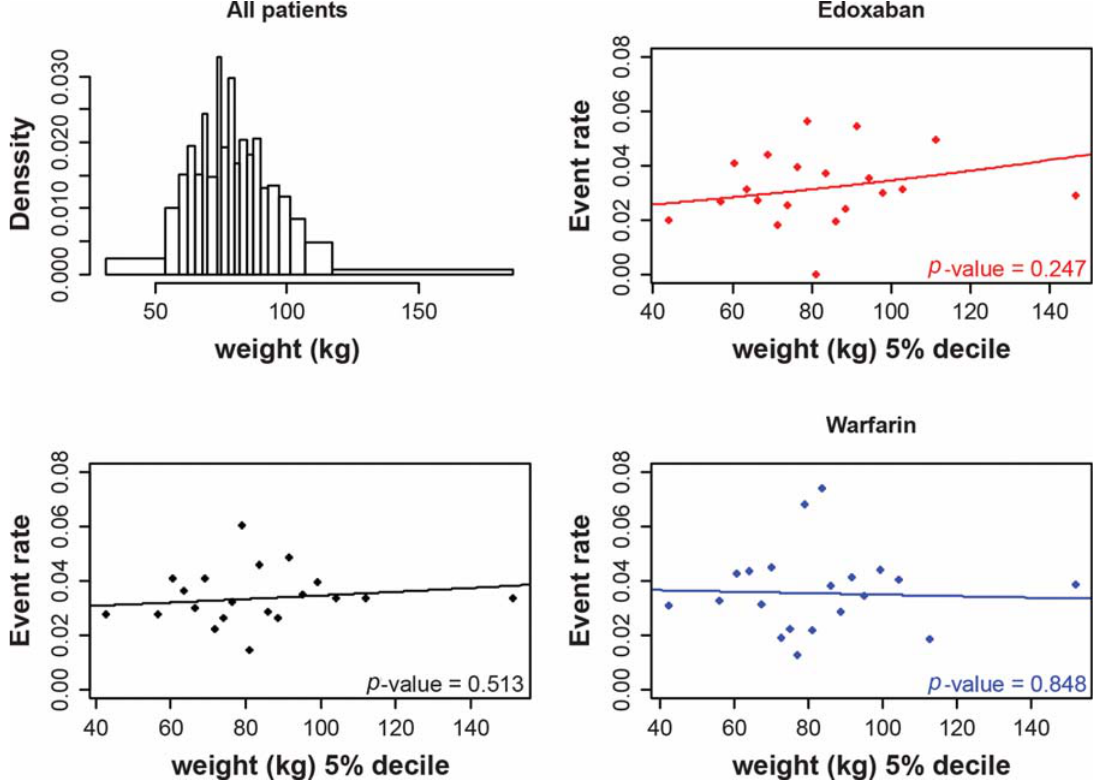
Fig. 3 The distribution of body weight and the relationship between VTE recurrence and body weight, overall and by treatment arm. VTE, venous